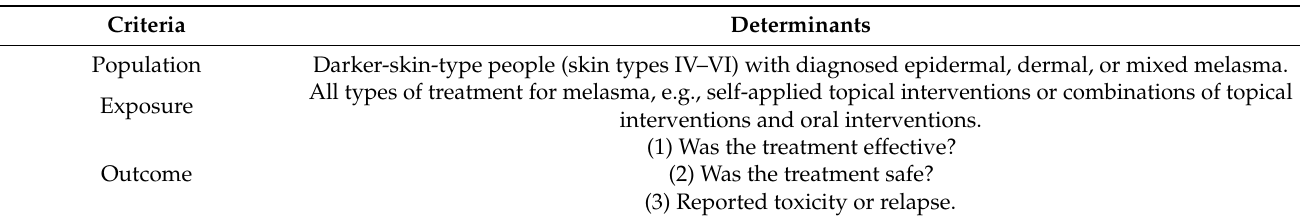
Table 1. The framework for determining the research question’s